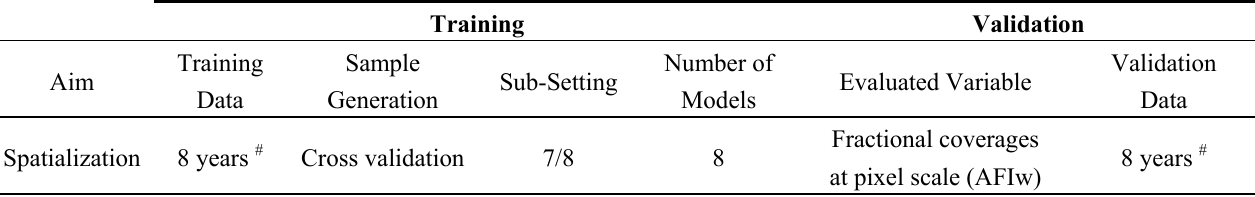
Table 2. Overview describing the experimental approach for mapping sub-pixel winter crop acreages from NOAA-AVHRR data. For training and evaluation, a dataset covering eight years was used. Independent estimates were obtained by means of